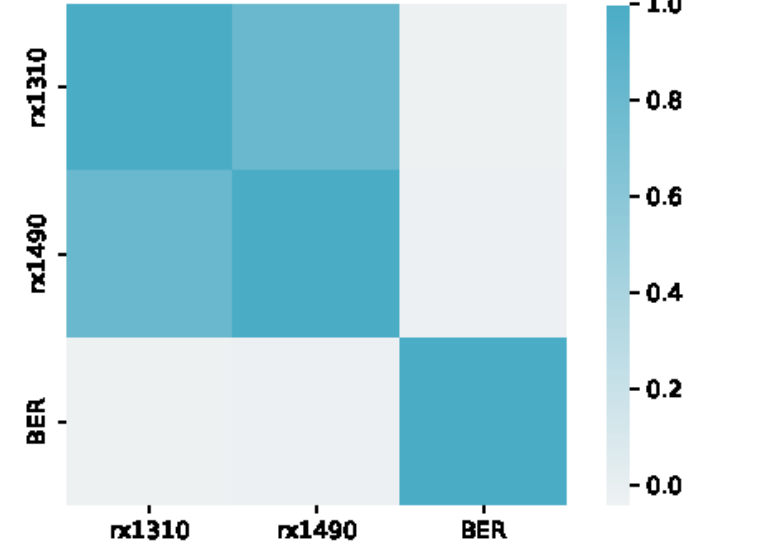
Figure 4. Correlation between GPON signal levels and